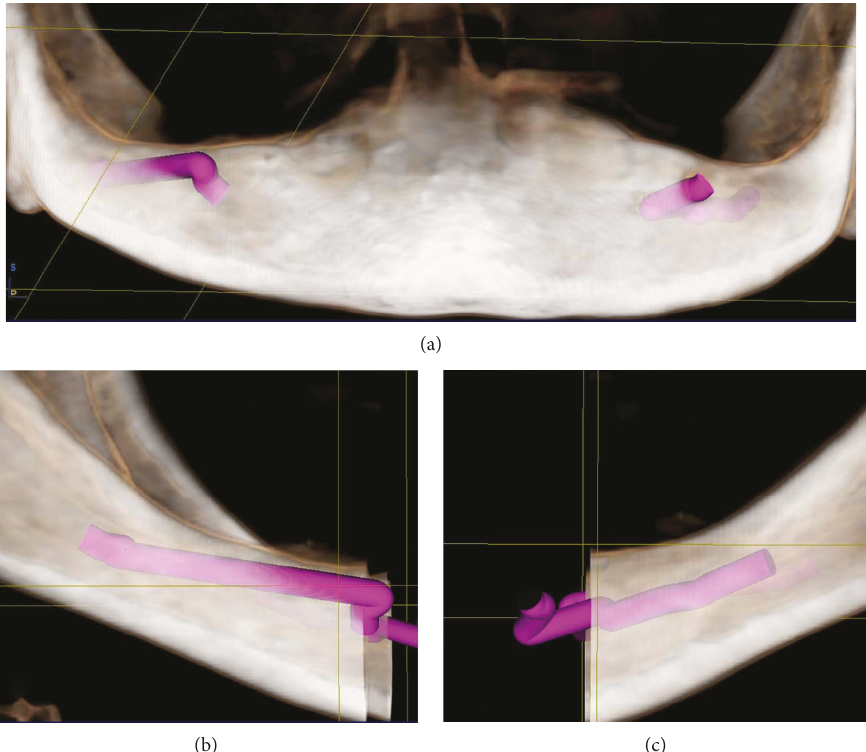
Figure 3: Tracking the path of inferior alveolar nerve and location of mental foramen for surgical implant placement: (a) frontal; (b) right side; (c) left